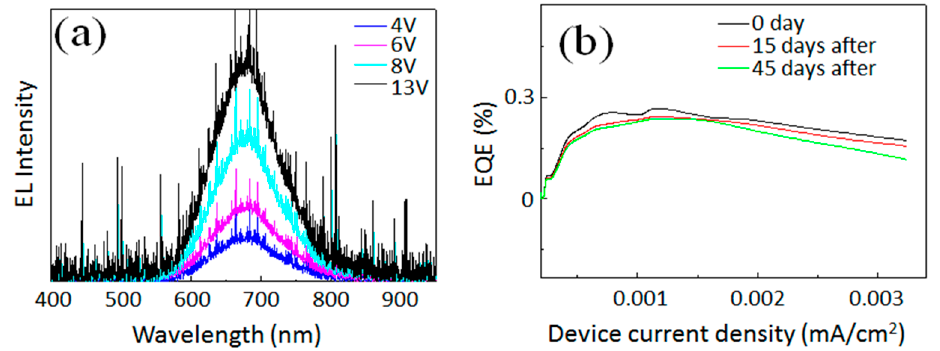
Figure 4. ( a ) Voltage variance of the EL spectra at di ff erent applied bias and ( b ) EQE value with device current density for three Si-QLEDs stored at 80% humidity in ambient air.